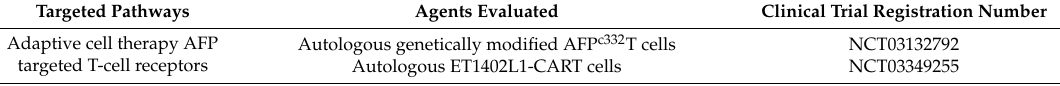
Table 5. Selective ongoing clinical trials of adaptive-cell therapies in hepatocellular carcinoma. Targeted Pathways Agents Evaluated Clinical Trial Registration